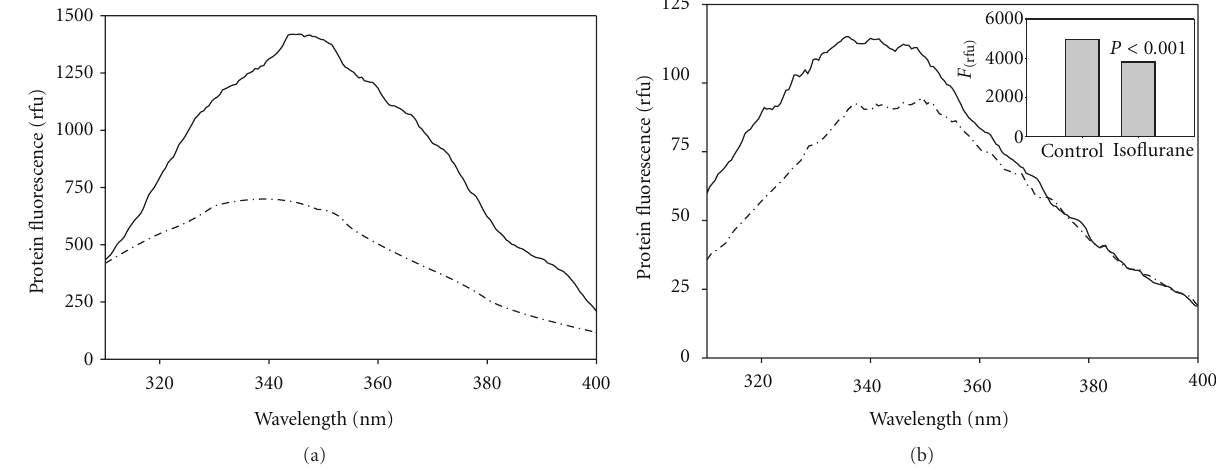
Figure 2: Comparison of fluorescence emission spectra after substantial dilution of HSA. Spectra before (a) and after (b) dilution: control (solid line) and isoflurane-treated (dash-dotted). Data obtained from representative samples. Spectra were integrated over 310 to 400 nm to obtain areas under the curve and compared (inset). Undiluted samples were measured at 1% attenuation of emission signal.